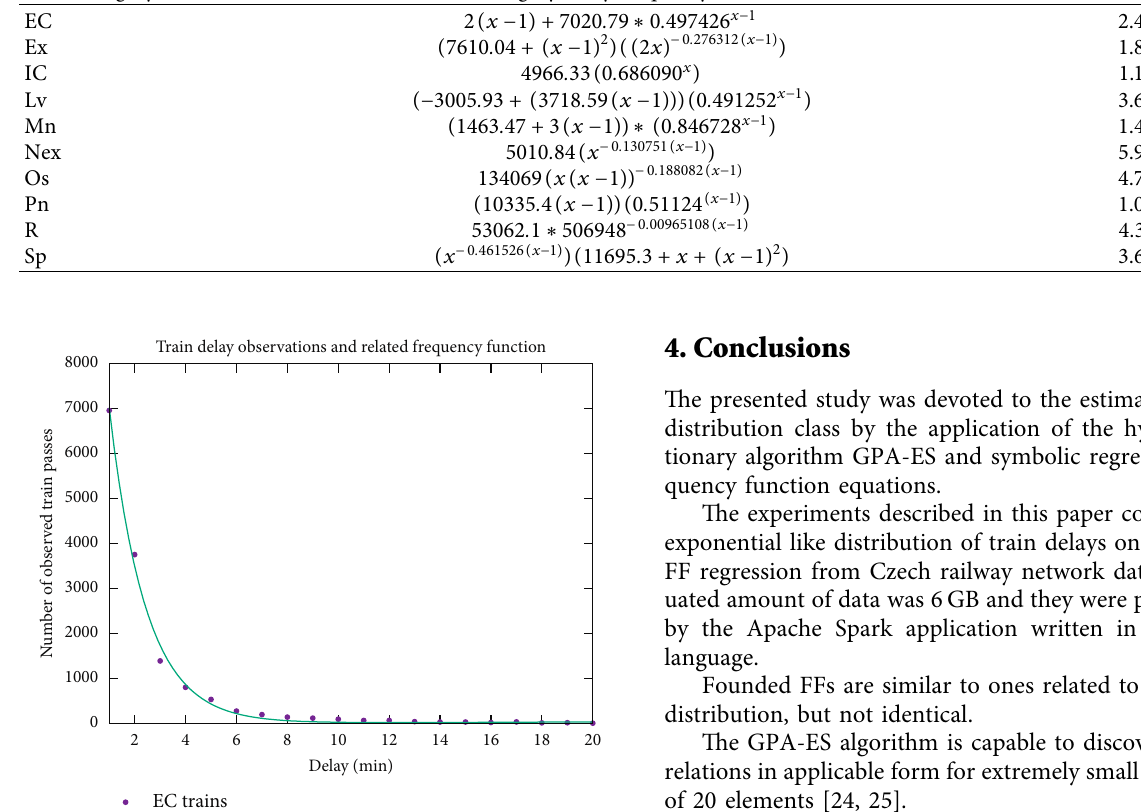
Table 2: The FFs discovered by the genetic programming algorithm and residual errors of this estimation. Train category